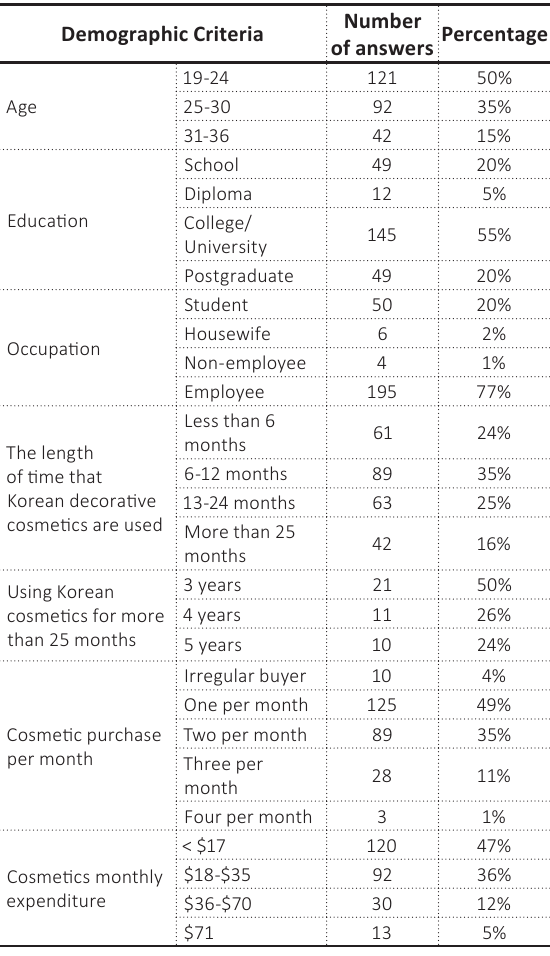
Table 2. Demographics of